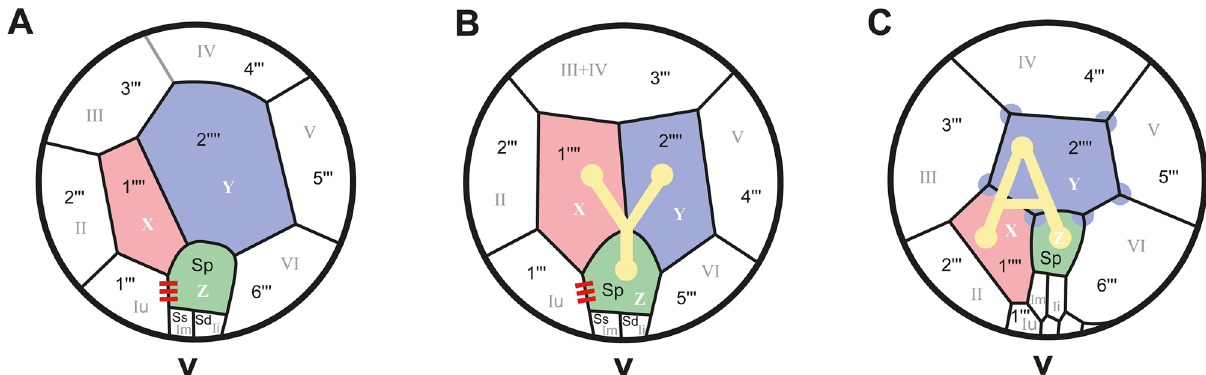
Figure 1. Schematics of hypothecae in armoured dinophytes. ( A ) Cladopyxidoid, ( B ) peridinialean, ( C ) gonyaulacalean: sexiform (modified 8 ). Putatively homologous plates are color-coded, using the AY-model system 17 . For plate labelling, we followed Kofoidean notation 23 (black lettering), while the Taylor-Evitt notation is in grey. Thus, our first antapical plate corresponds to a posterior intercalary plate, and our second antapical plate corresponds to the only antapical plate 3,8,17,18 . Note the (putatively ancestral) connection between